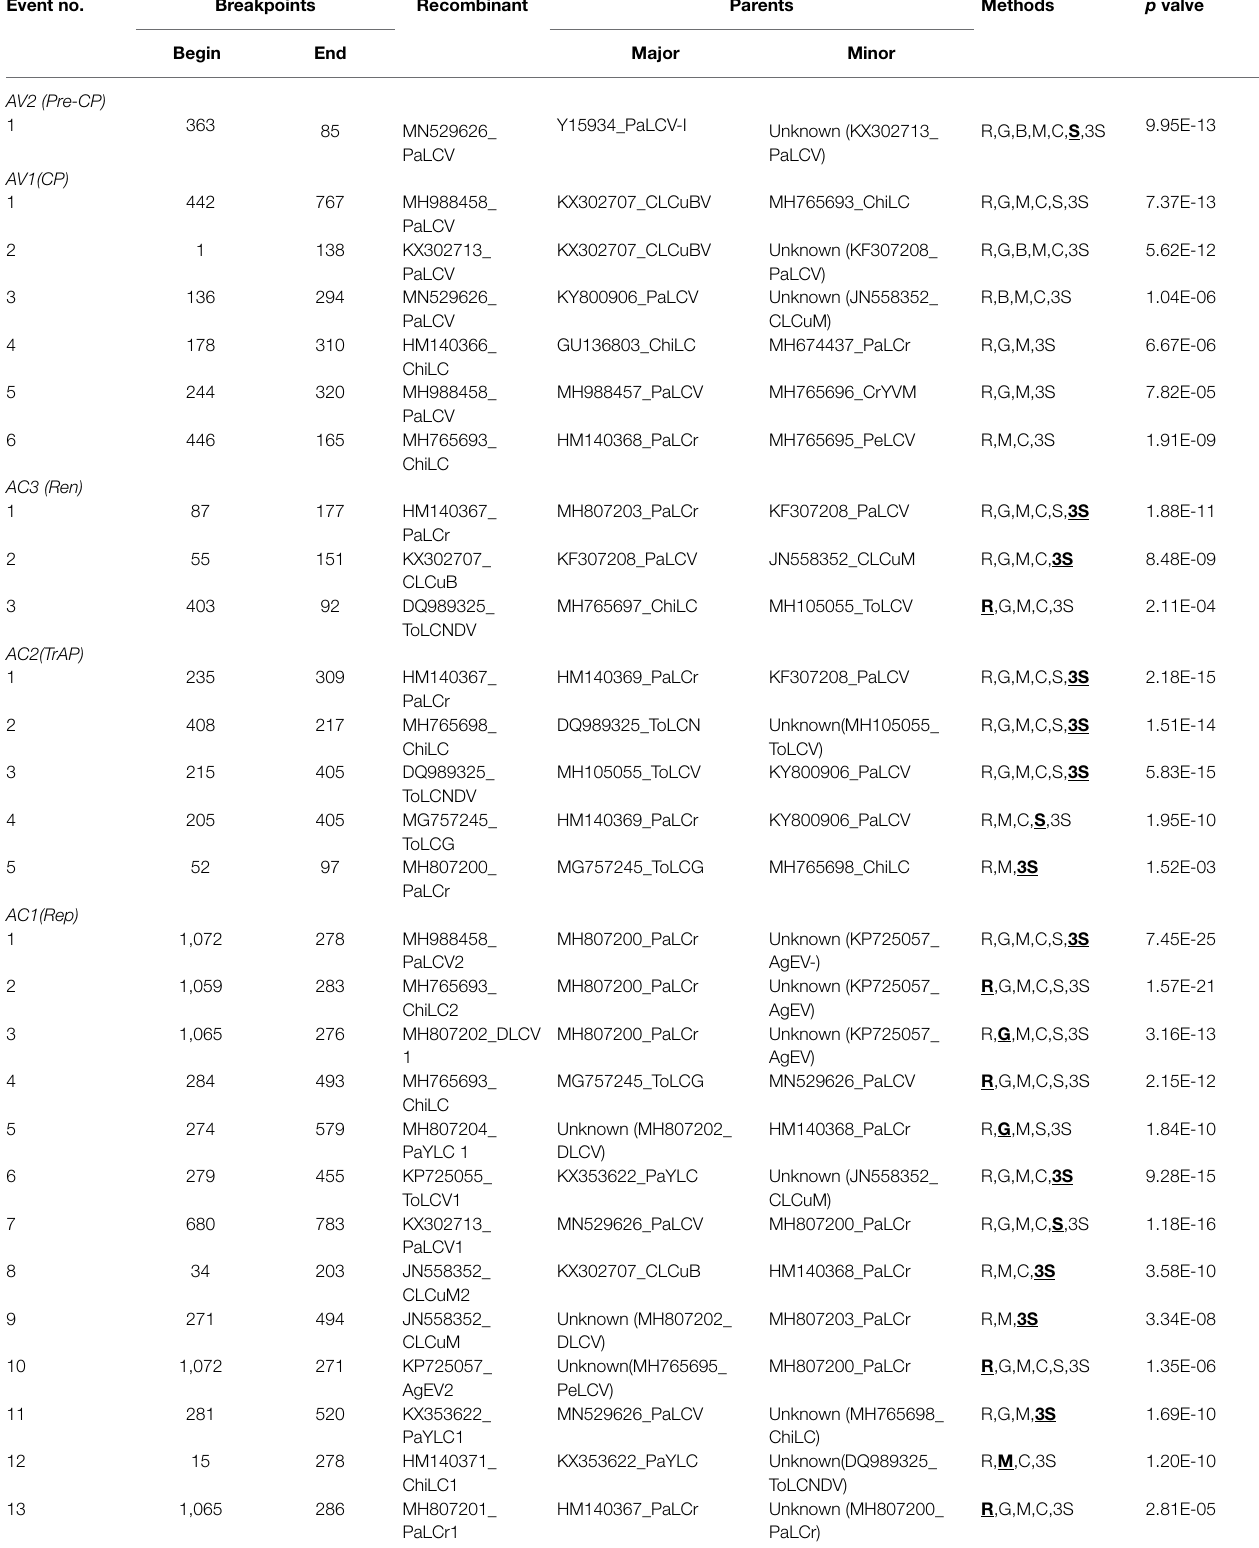
TABLE 4 | Putative recombination events detected using the RDP4.1 program among genes of begomoviruses associated with PaLCD, based on provided datasets from India; six genes/ORF’s of 44 DNA-A sequences. Event